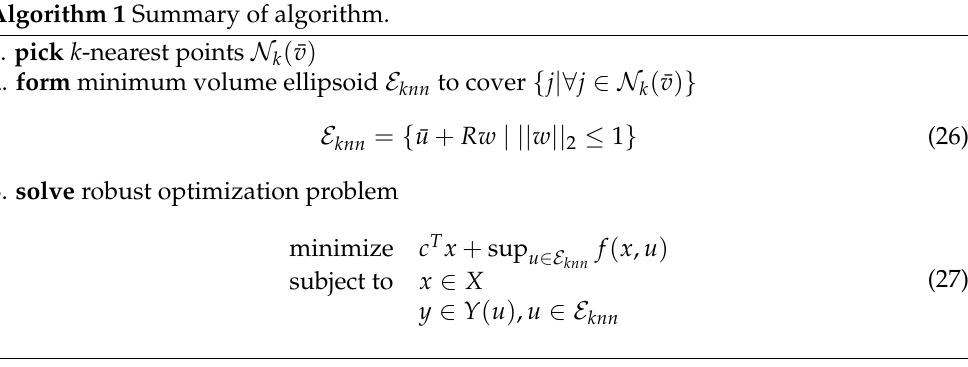
Algorithm 1 Summary of